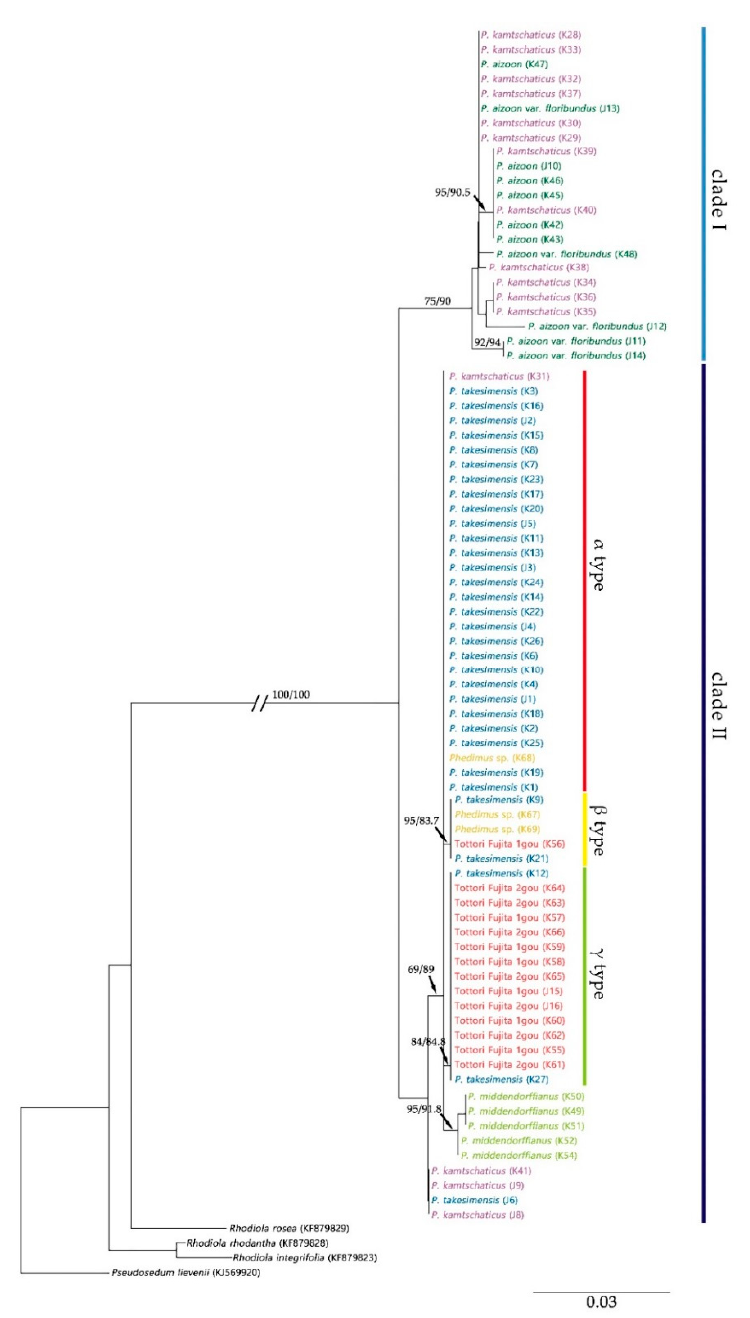
Figure 3. Maximum likelihood (ML) tree of the genus Phedimus based on ITS sequence. Numbers on the branches indicate the bootstrap values and Shimodaira–Hasegawa (SH)-like approximate likelihood ratio test (SH-aLRT) support.